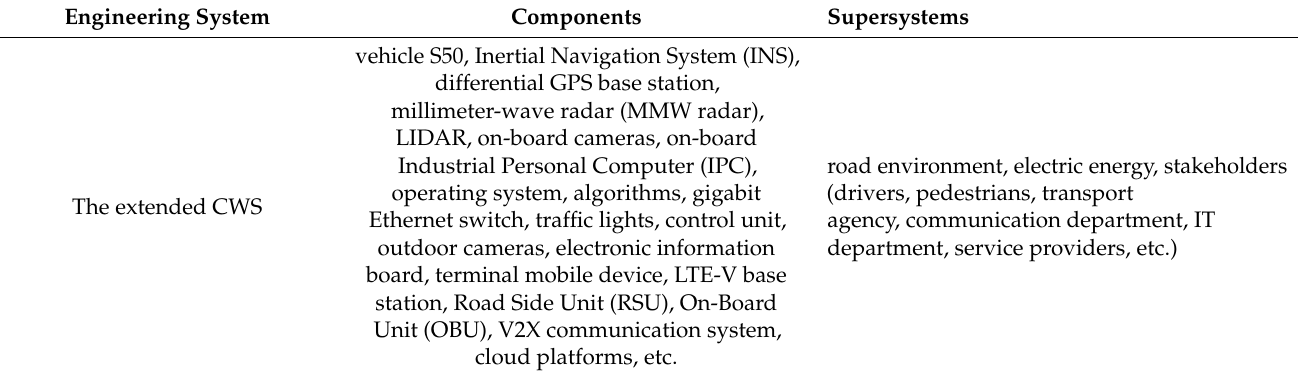
Table 2. Elements of extended CWS.